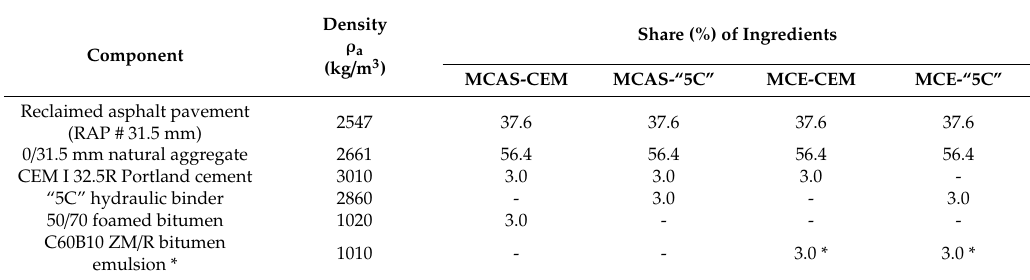
Table 4. Composition of the MCAS / MCE cold-recycled